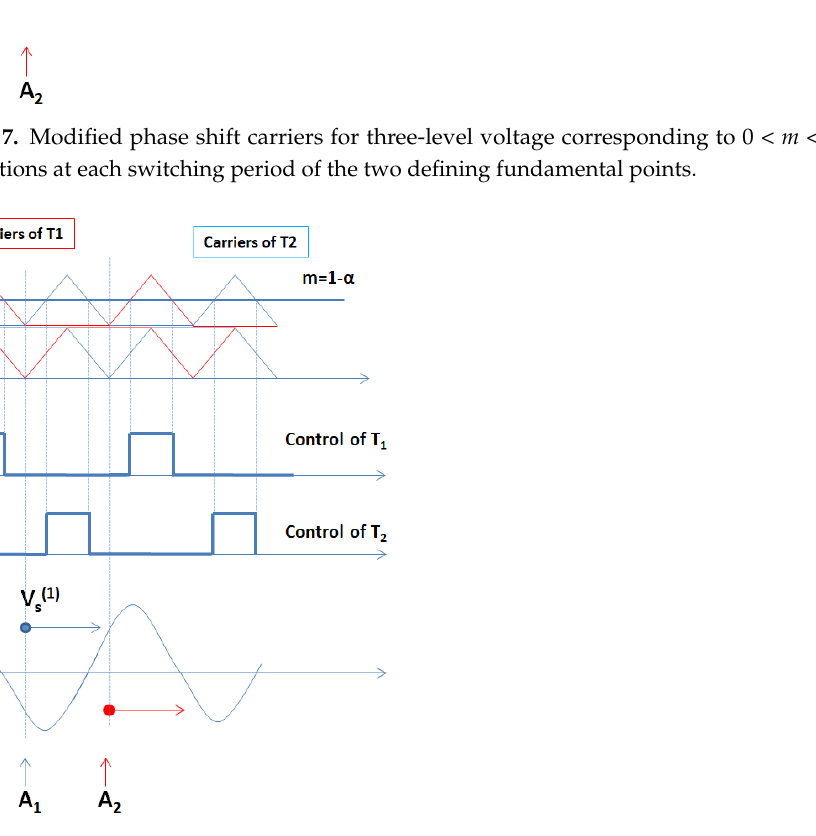
Figure 8. Modified phase shift carriers for three-level voltage corresponding to 1/2 < m < 1 and acquisitions at each switching period of the two defining fundamental points.